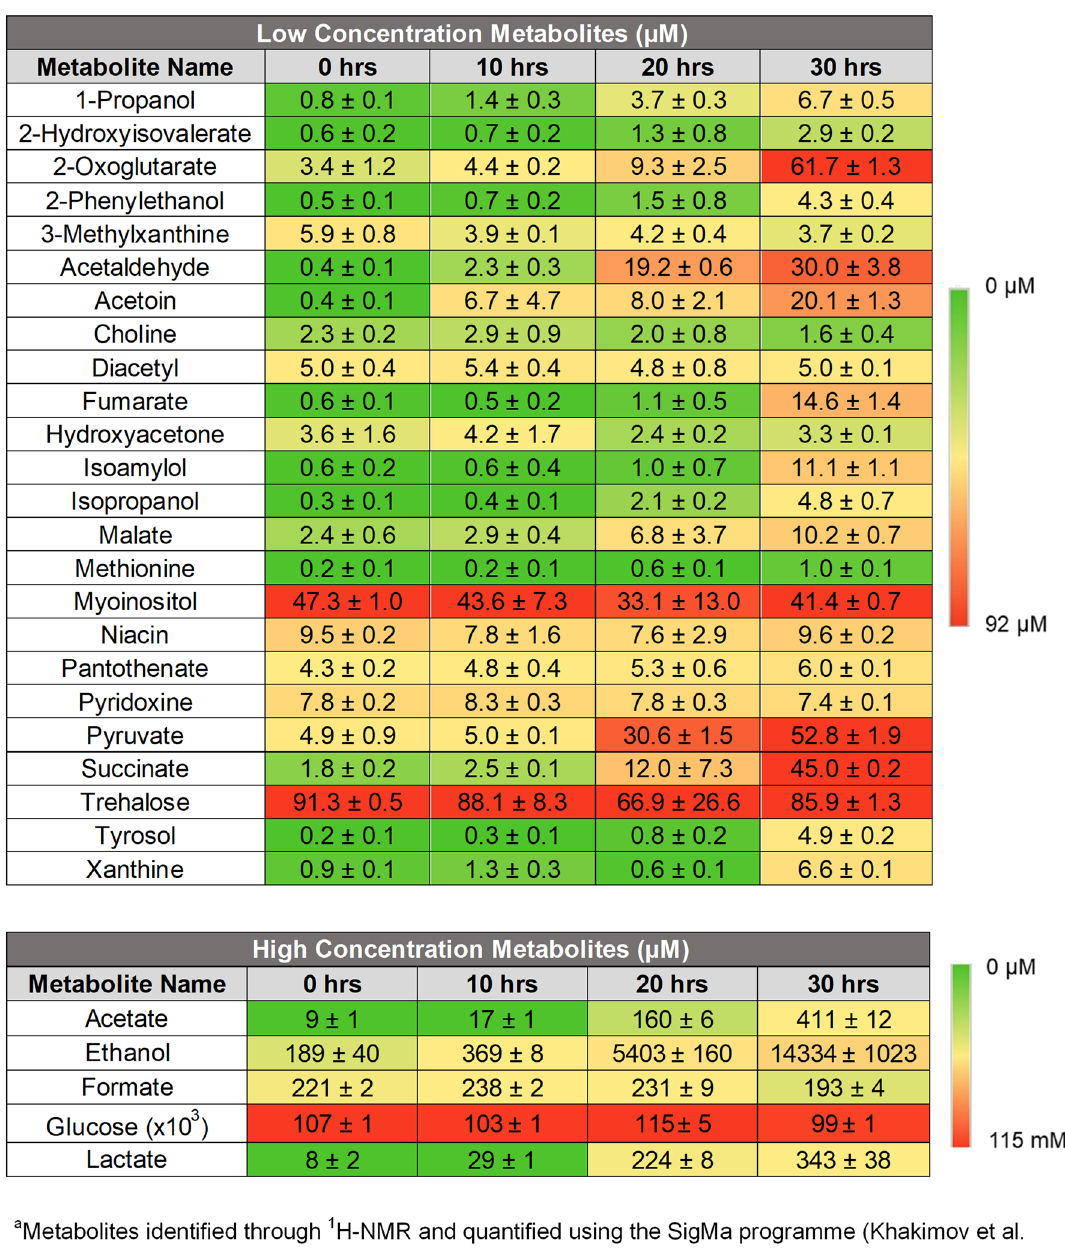
Table 1. Heatmap of the physiological concentrations of compounds detected under low nitrogen conditions during growth of S. cerevisiae strain Σ1278b a